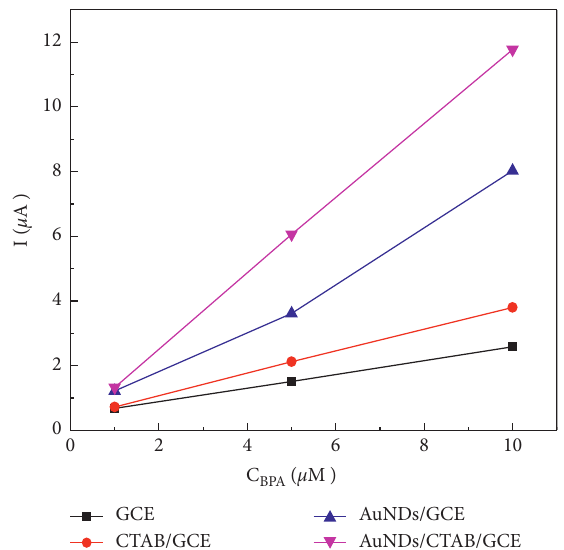
Figure 6: Peak current of BPA at 1.0, 5.0, and 10.0 µ m on GCE, CTAB/GCE, AuNDs/GCE, and AuNDs/CTAB/GCE recorded in PBS pH 7.